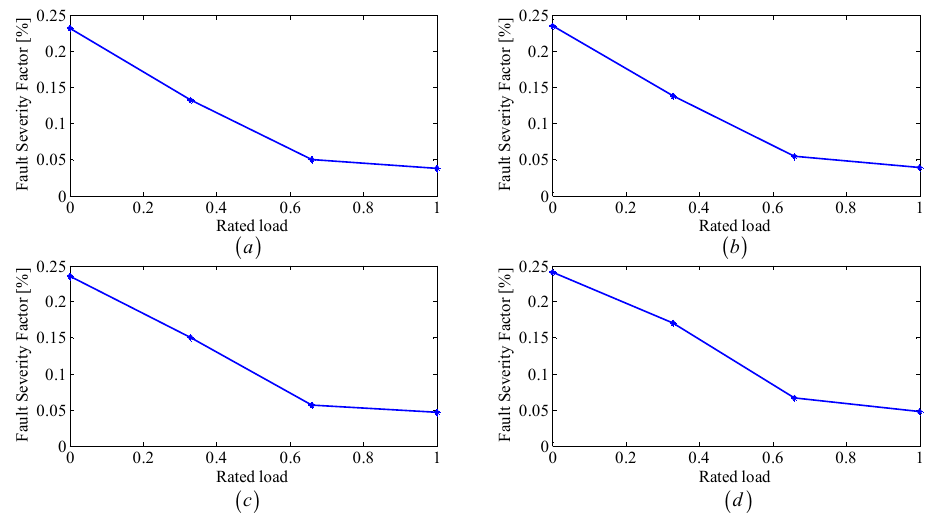
Table 2. The amplitudes of FSF at a frequency of 2 to full load.